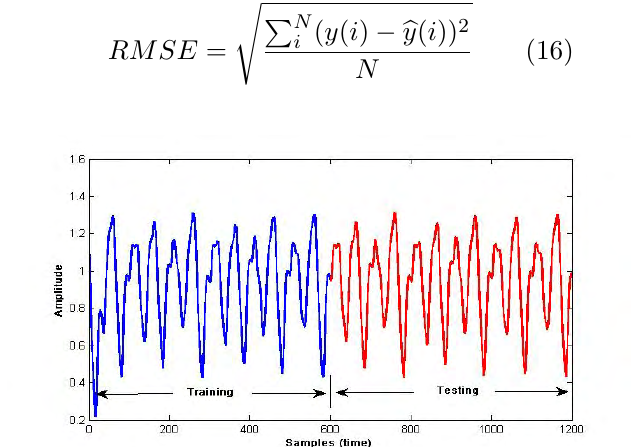
Fig. 3. Mackey-Glass time series